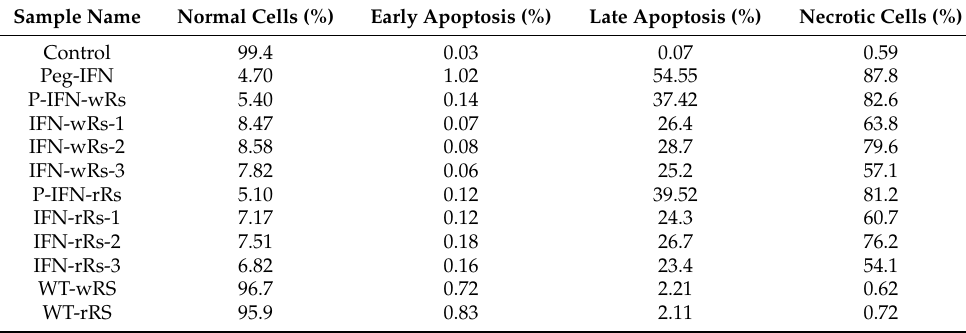
Table 3. Effect of recombinant IFN- α 2a on Hep-G2 cell apoptosis at various